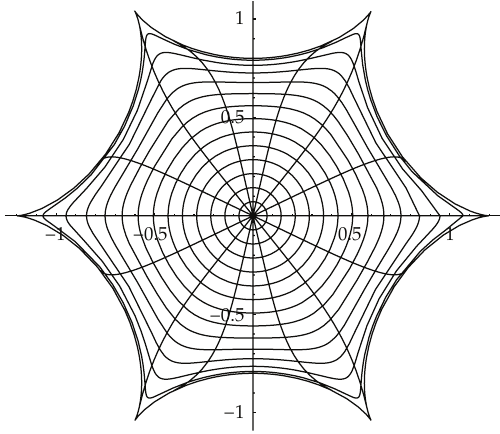
Figure 2: The image of f (cid:3) z (cid:4) (cid:5) z (cid:6) (cid:3) 1 / 5 (cid:4) z 5